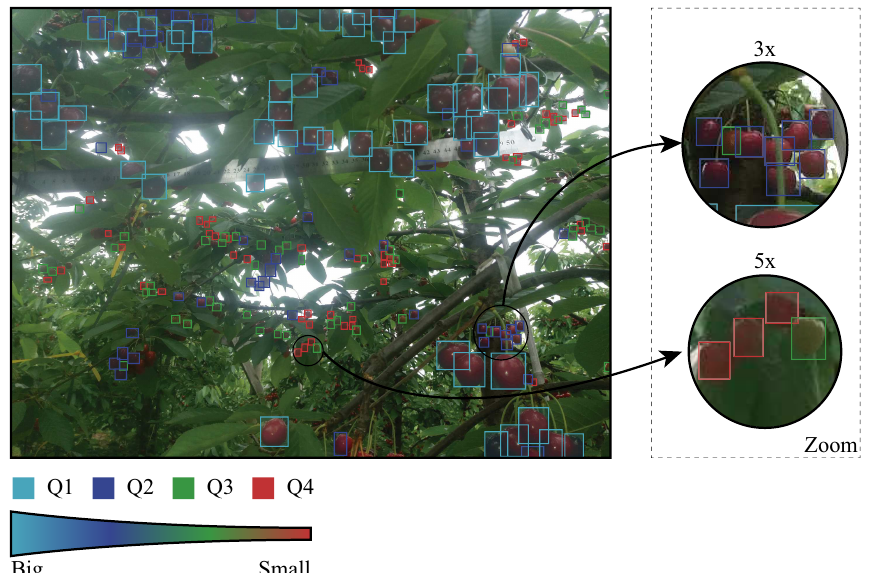
Figure 7. Example of cherry detection. The total number of cherries are divided into four groups (with an equal number of cherries). From the biggest to the smallest size detected: light blue, blue, green, and red.